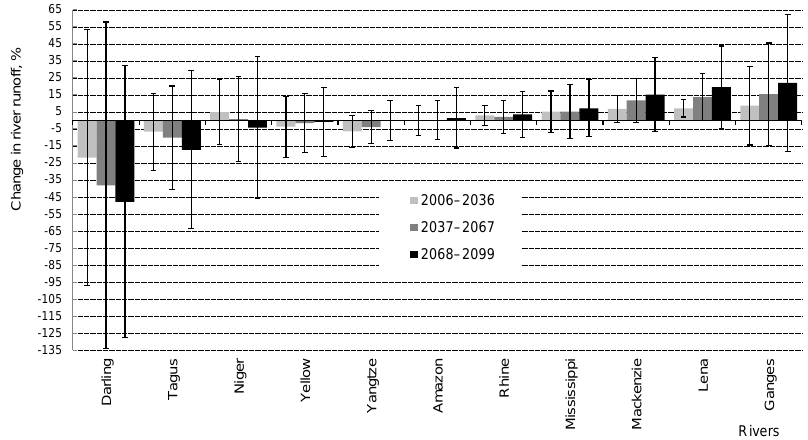
Figure 2. The projected mean relative changes in annual values of climatic river runoff and their uncertainties caused by both the GCMs structural uncertainty and the RCP scenario differences. Bars are the intervals ( M ± 1.96SD) treated as hydrological uncertainty.